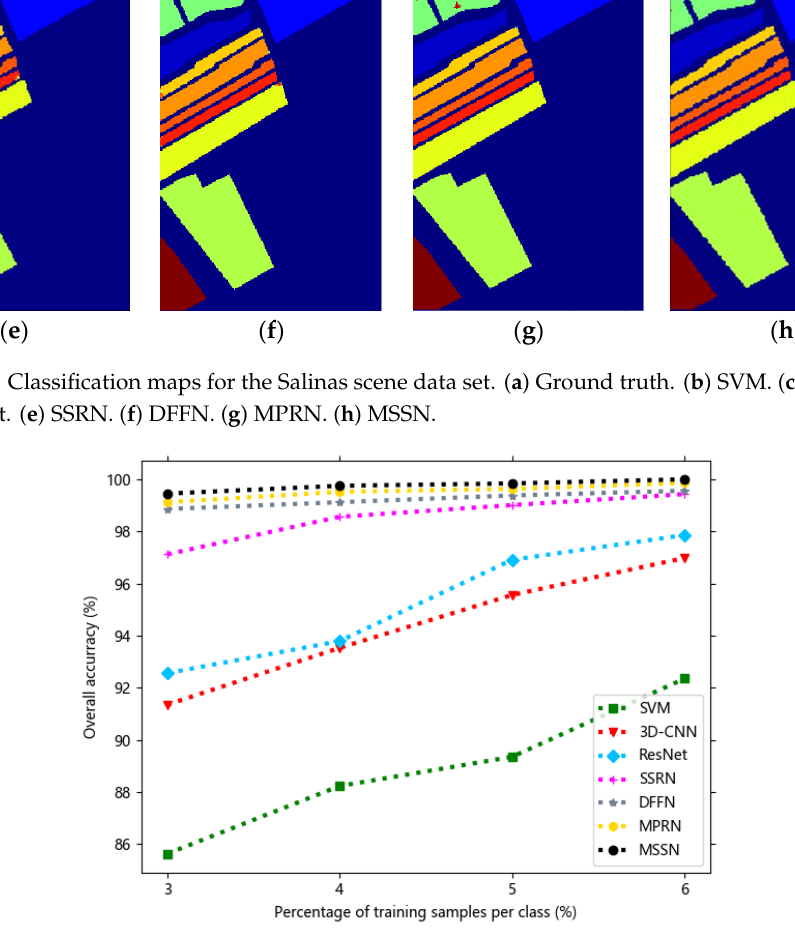
Figure 14. Overall classification accuracies obtained by different methods when considering different percentages of training samples on the Salinas scene data set.